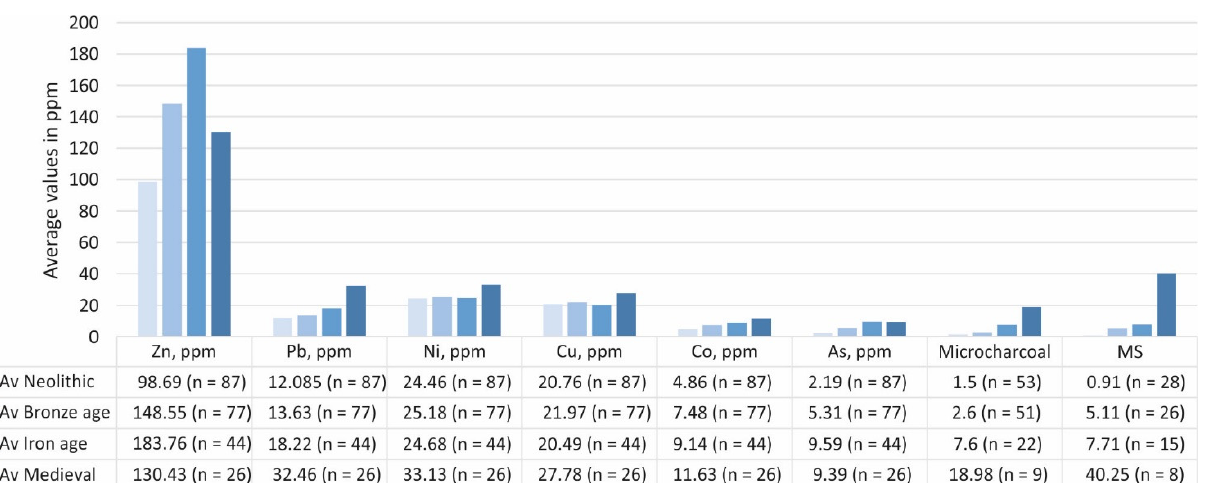
Figure 3. The maximum values of element concentrations in the Kamyshovoe Lake sediments ac- cording to historical period. The results showed that the geochemical elements under consideration do not fol- low a uniform trend from the Neolithic to the early Medieval period, though the con- centrations of almost all the elements show increased values towards the upper part of the core. The average values of most of the elements together with microcharcoal and MS reached a maximum during the Medieval period. The exception was Zn, which had a clear peak during the Iron Age, and As with nearly the same concentration during the Iron Age and the Middle Ages. The values of such elements as Pb, Co and As in the Iron Age and the Medieval period became 2–3 times higher than in Neolithic, while concen- tration of Cu and Ni grew smoothly. Regarding the highest concentrations throughout the historical periods, the pattern was slightly different. While maximum value trends of Pb, Zn, Co and As coincided with